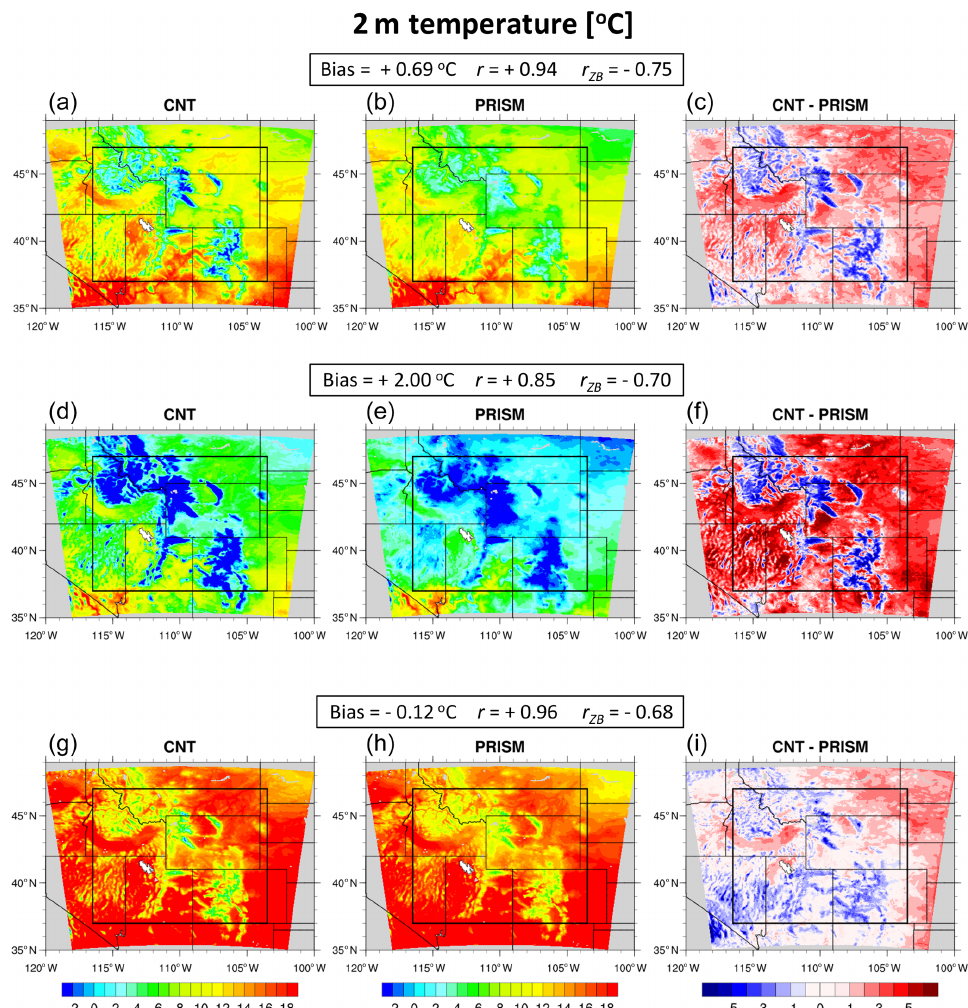
Figure 3. T av (a, b, c) , T min (d, e, f) , and T max (g, h, i) averaged from February through July. CNT results are shown in column 1, PRISM results are shown in column 2, and CNT minus PRISM (bias) results are shown in column 3. The black box denotes the region of the domain in which biases and other statistics are computed. Mean bias, r value, and r ZB value are given for each